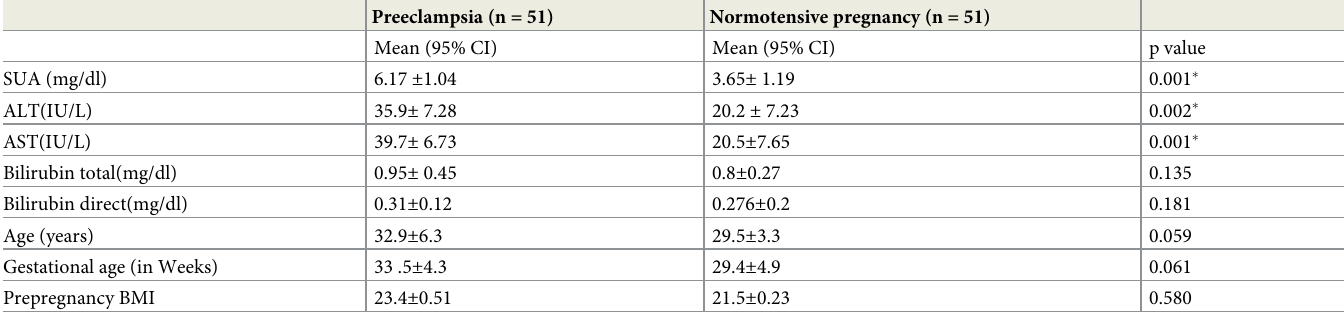
Table 2. Independent t-test for mean comparison of serum uric acid and liver function tests between preeclamptic and normotensive pregnant women, University of Gondar Comprehensive Specialized Hospital, Northwest